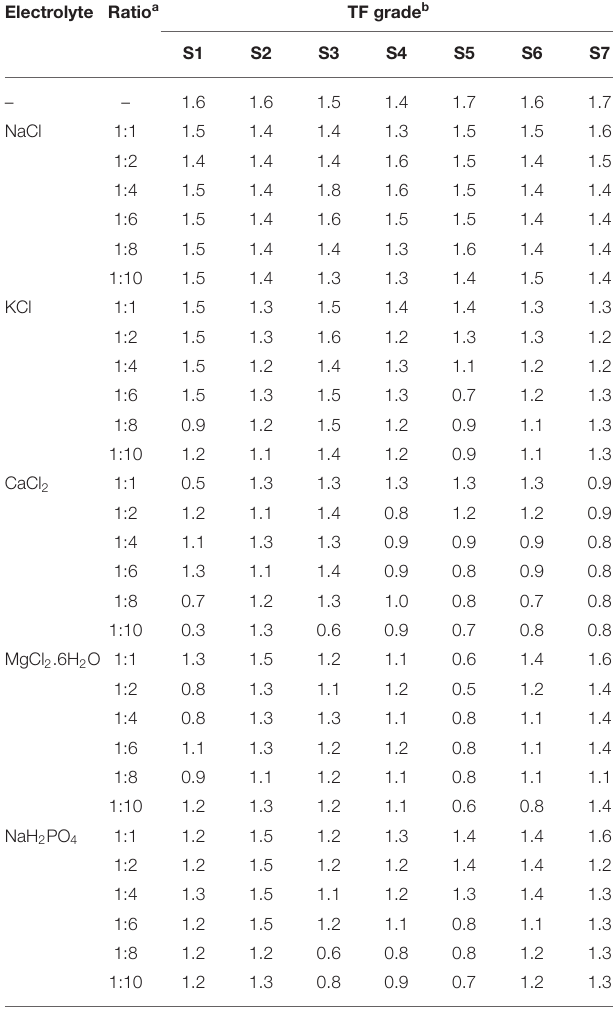
TABLE 2 | Tear ferning grades of sheep tears mixed with various electrolyte solutions. Electrolyte Ratio a